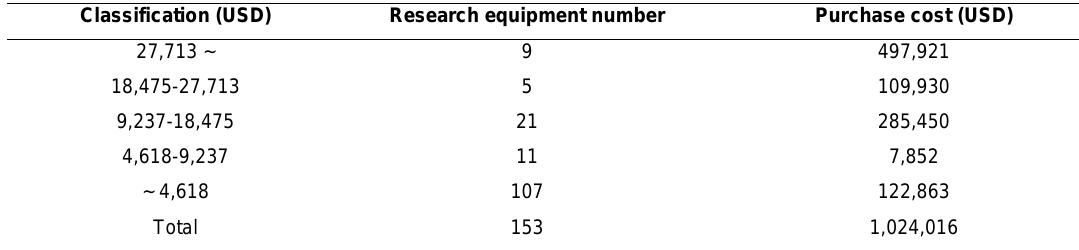
Table 1. Status of research